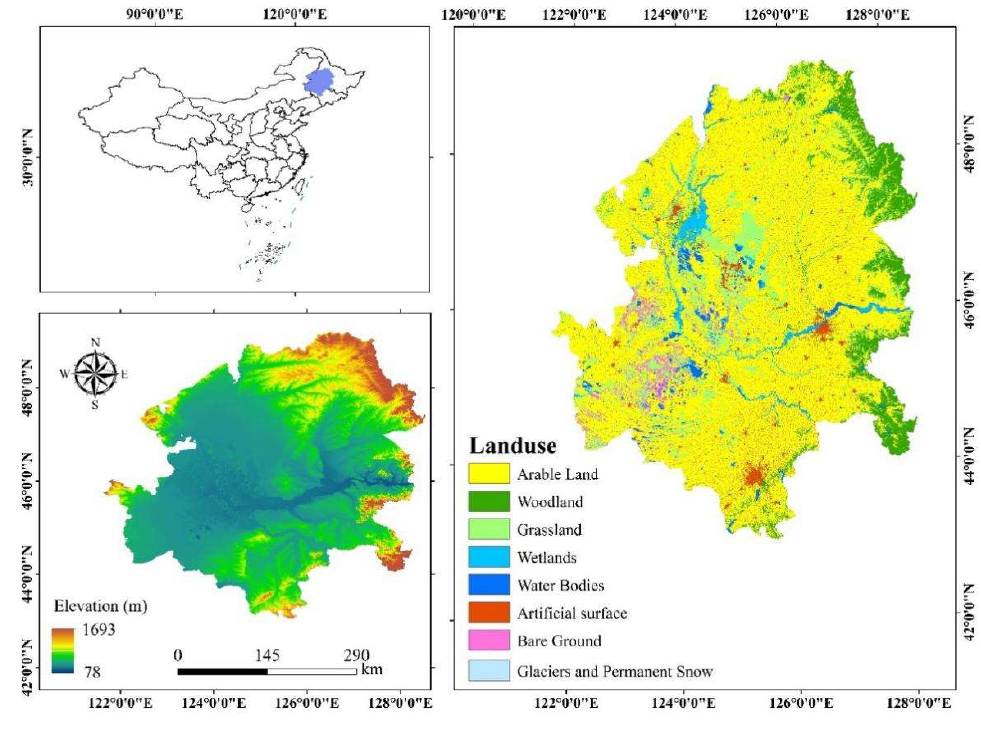
Figure 1. Location Figure 1. Location site.